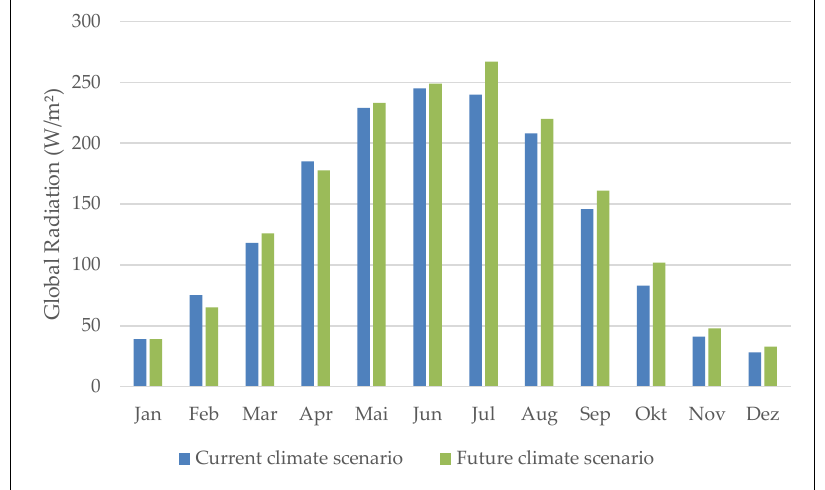
Figure 3. Monthly global radiation based on long-term measurements (1991 – 2010) for the location Wien Hohe Warte [30].